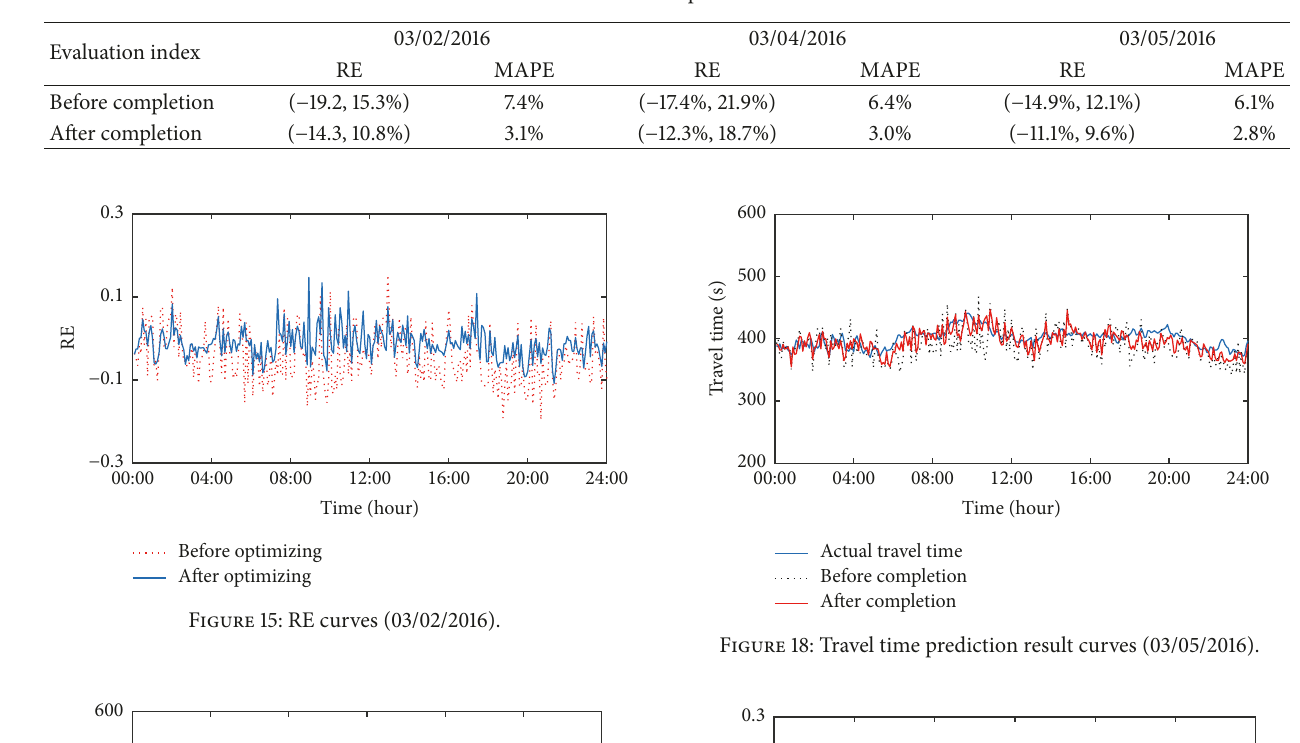
Table 8: Travel time prediction error.